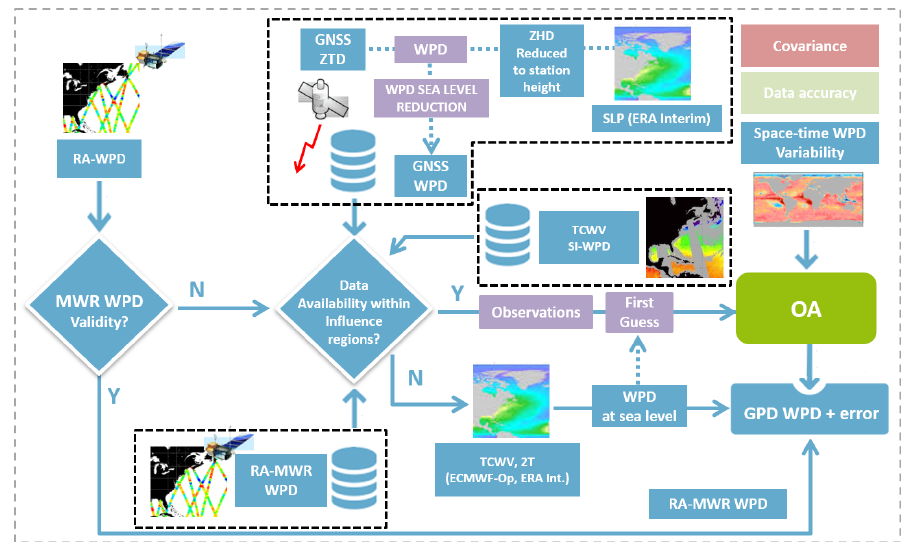
Figure 5. Fluxogram of the GPD + algorithm.